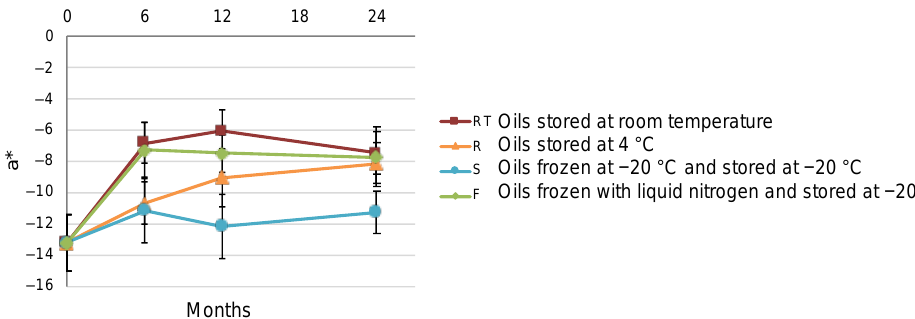
Figure 1. Interaction plot between the factor storage time and the factor storage temperature and freezing method for the chromatic coordinate a * (study I). Error bars correspond to the standard deviation.